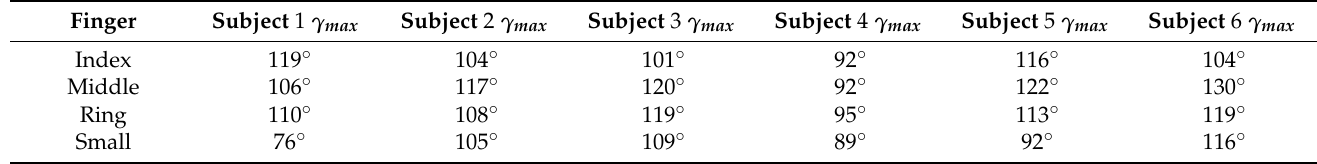
Table 4. The angle ( ◦ ) of movement of every finger among the